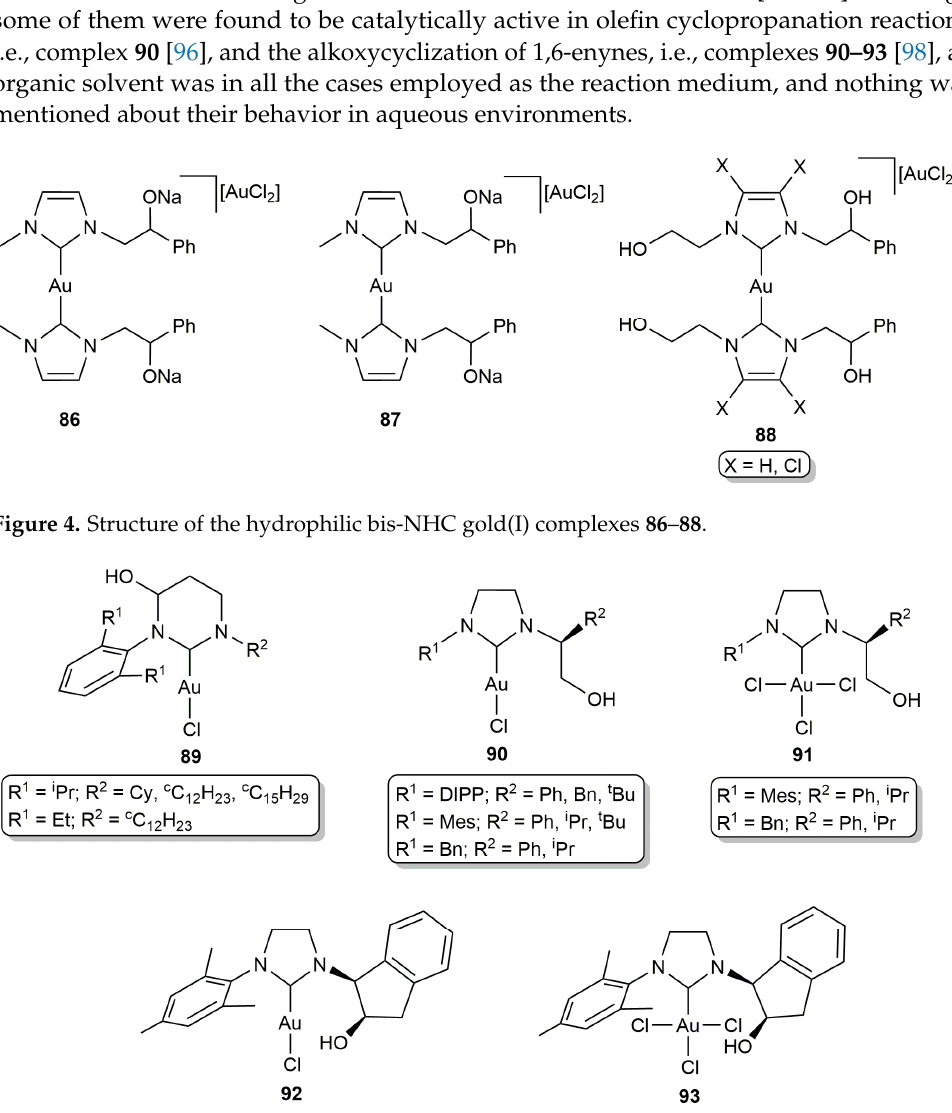
Figure 5. Structure of the hydrophilic bis-NHC gold(I) complexes 89–93 .